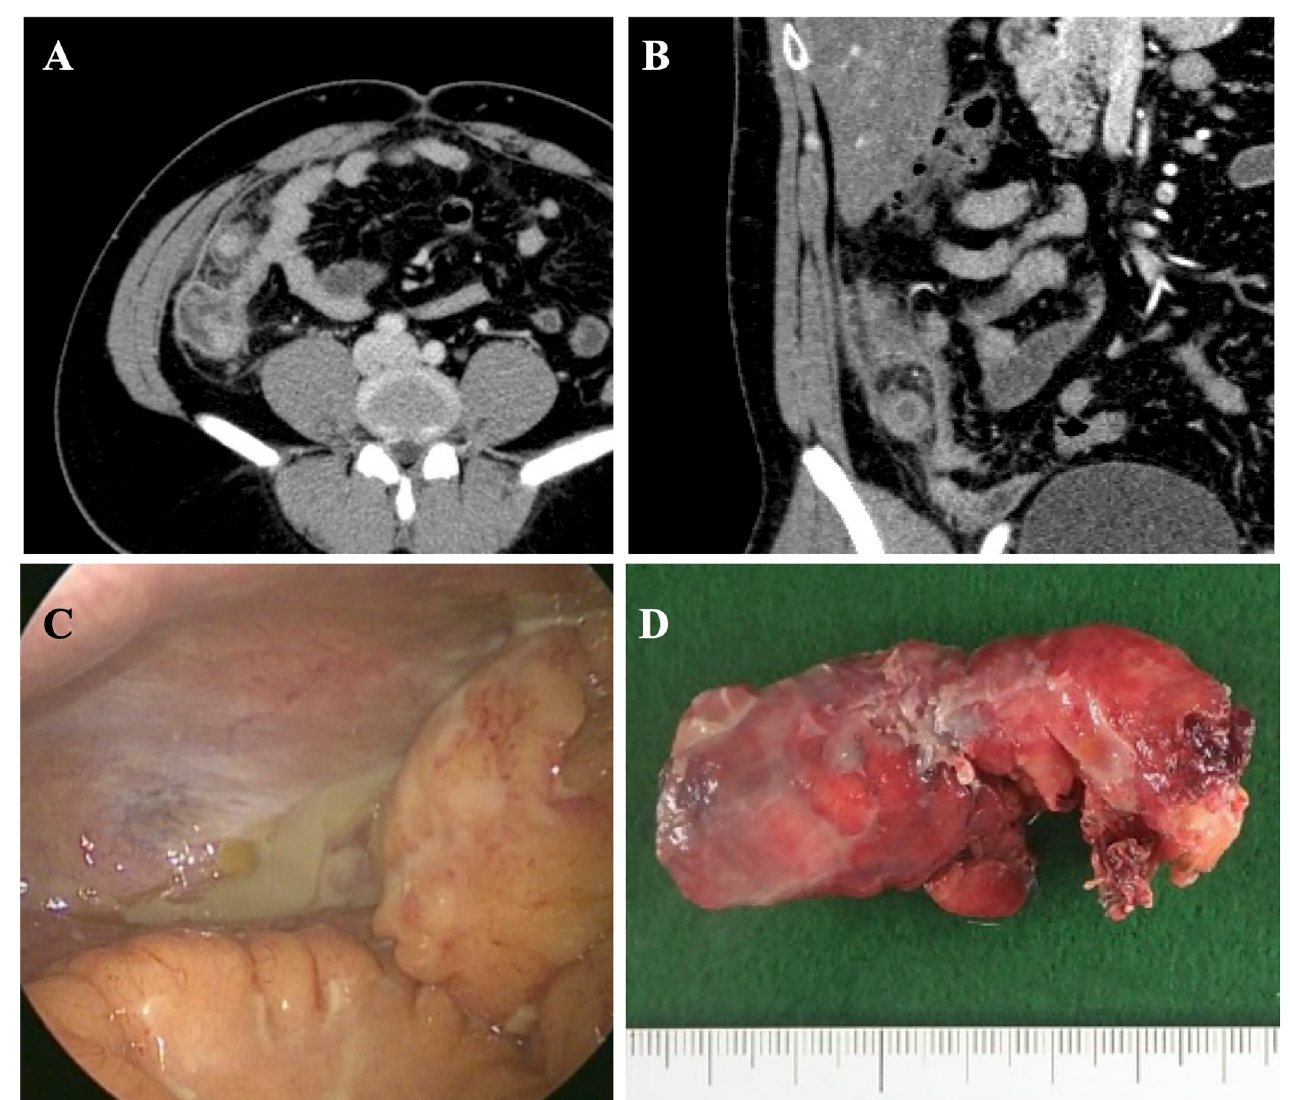
Fig 1. A case of complicated appendicitis. (A, B) Computed tomography images (A, transverse plane; B, coronal plane). A swollen appendix, stranding of the adjacent fat, and fluid collection are found; no obvious abscess is detected. (C) View during abdominal laparoscopy. Collection of infected fluid is found on the right side of abdomen. (D) Macroscopic image of the resected appendix. The appendix did not have signs of necrosis or perforation and was diagnosed as phlegmonous